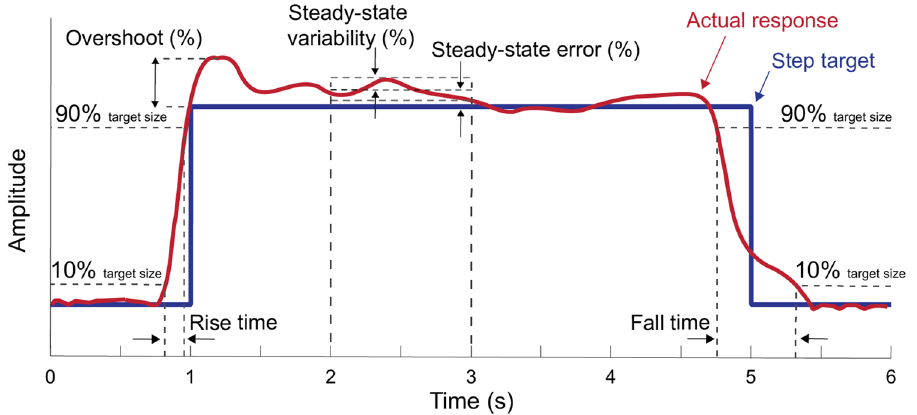
Figure 2. Step response characteristics. The empirical response (red line) and the step target (blue) line are shown for a single segmented target step response 6 s in length. For force-magnitude control, the step target size is in bodyweights, and for force-position control, the step target size is in centimeters. The evaluated control characteristics include rise time (s), bandwidth (Hz), overshoot (%), steady-state error (%), steady-state variability (%), and fall time